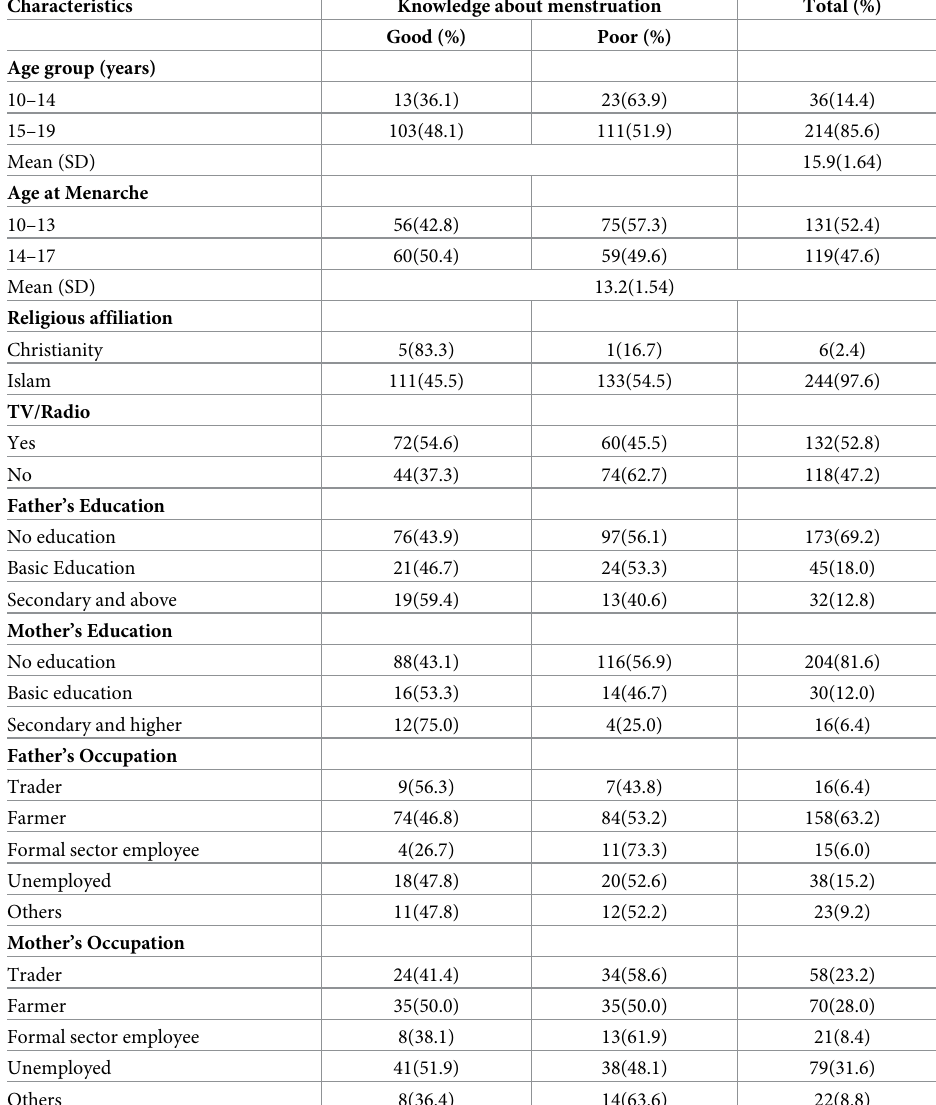
Table 1. Sociodemographic characteristics of adolescent